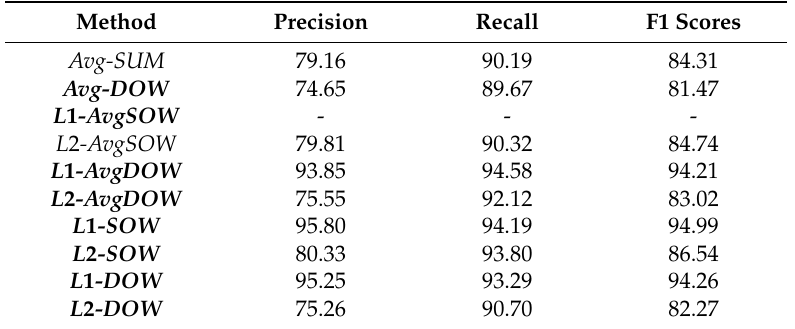
Table 6. Results of normalized representation of sentence vectors on SemEval-2015 dataset.